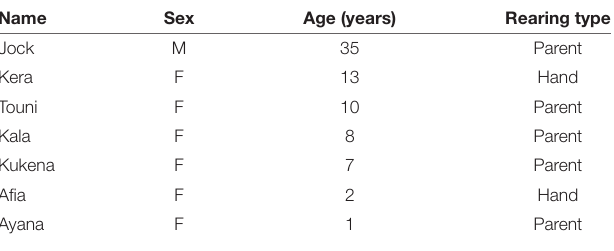
TABLE 1 | Information on gorilla study subjects at Bristol Zoo Gardens.